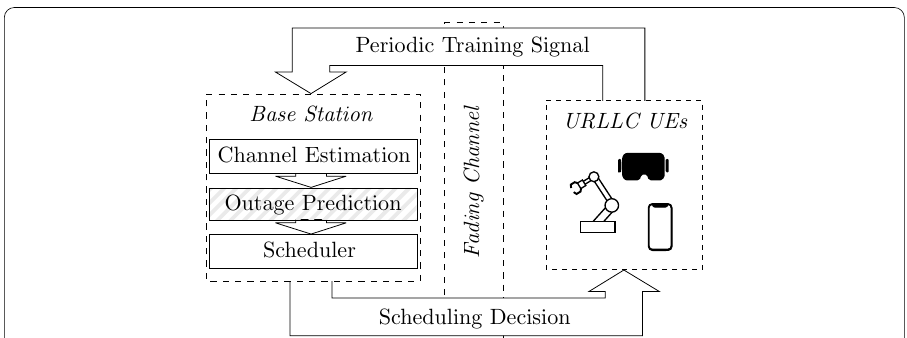
Fig. 2 Overall system model. The outage predictor is highlighted and topic of this